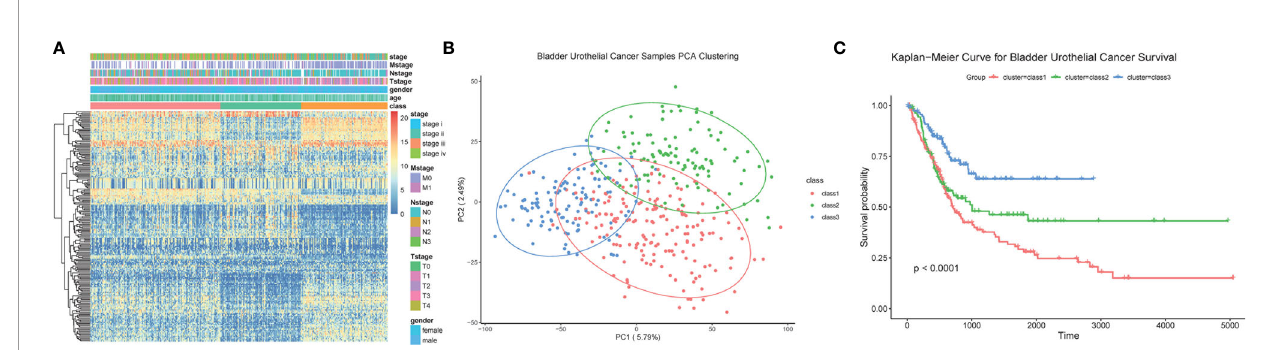
FIGURE 3 | Classi fi cation of BC patients. (A) Heatmap for the expression of top 200 high variable genes. Clinical information was annotated for subclasses. (B) PCA plot for the assigned subclasses. (C) Kaplan – Meier survival analysis for BC patients grouped into three subclasses. Log Rank test comparing overall survival between the class1 and class3 subtypes reached a p < 0.001. For the comparison between class 2 and class 3, p value <0.01. For class 1 and class 2, p = 0.067.